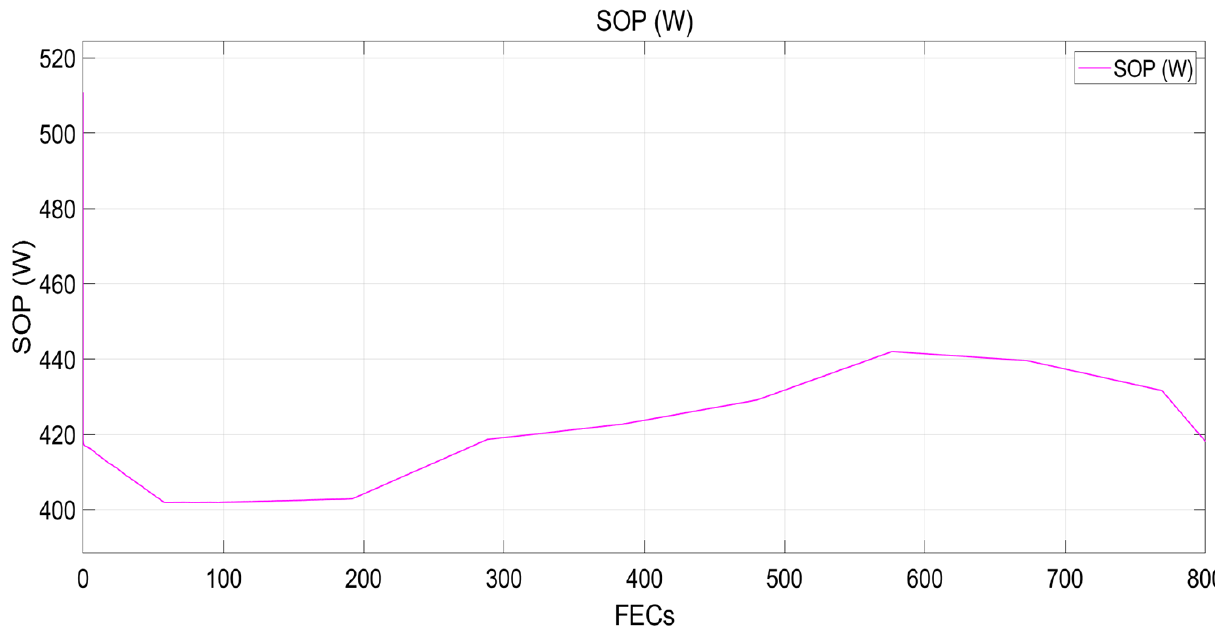
Figure 13. SoP output of the cell through 800 FECs.